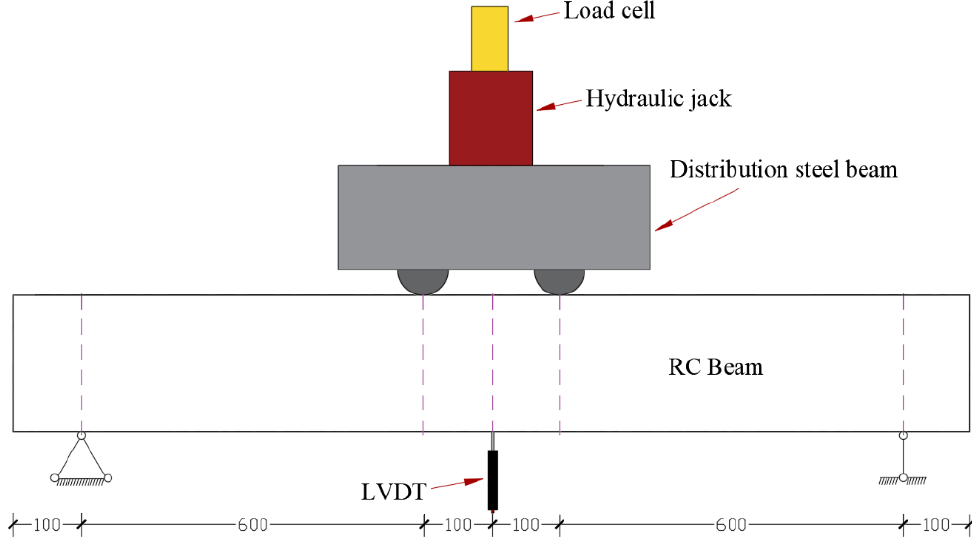
Figure 5. Test setup and instrumentation arrangement for flexural testing.